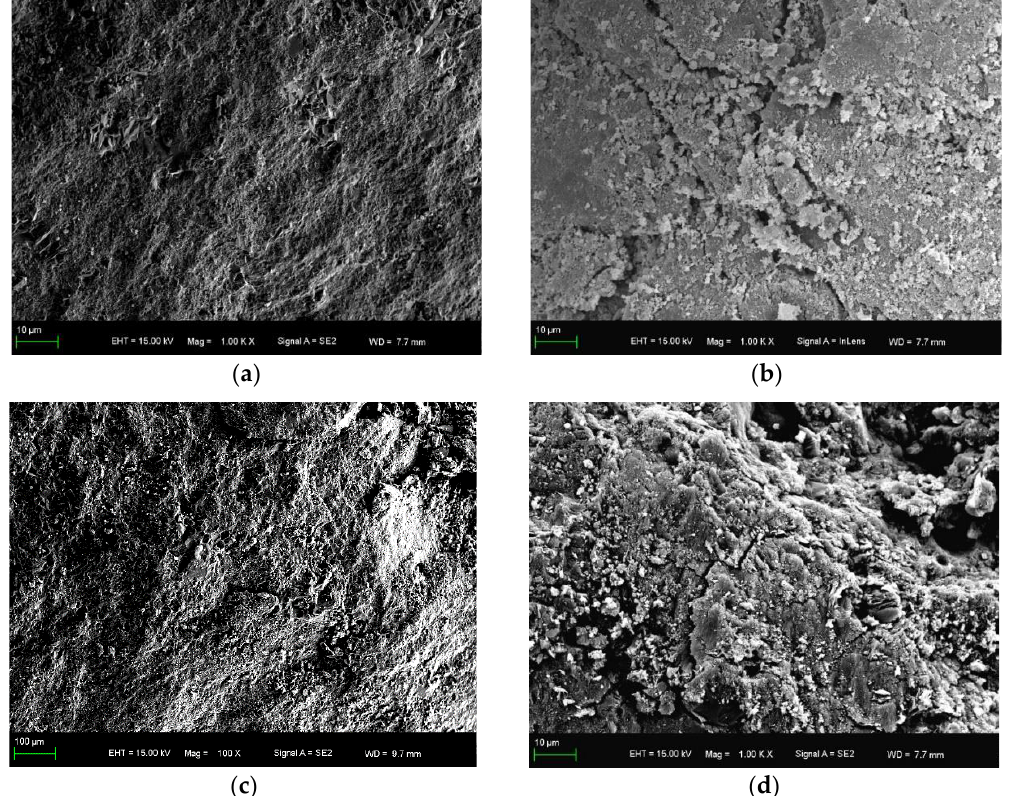
Figure 20. SEM images of specimen under a different number of F – T cycles: ( a ) SF0 with 0 F – T cycles, ( b ) SF0 with 200 F – T cycles, ( c ) SF10 with 0 F – T cycles and ( d ) SF10 with 200 F – T cycles.